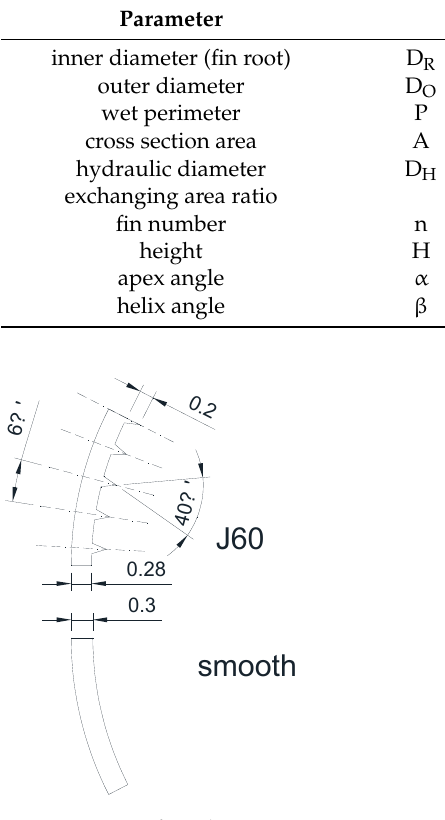
Figure 3. Microfin tube.